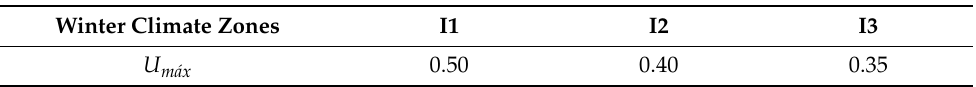
Table 4. Thermal coefficients for the opaque envelope of new or retrofitted